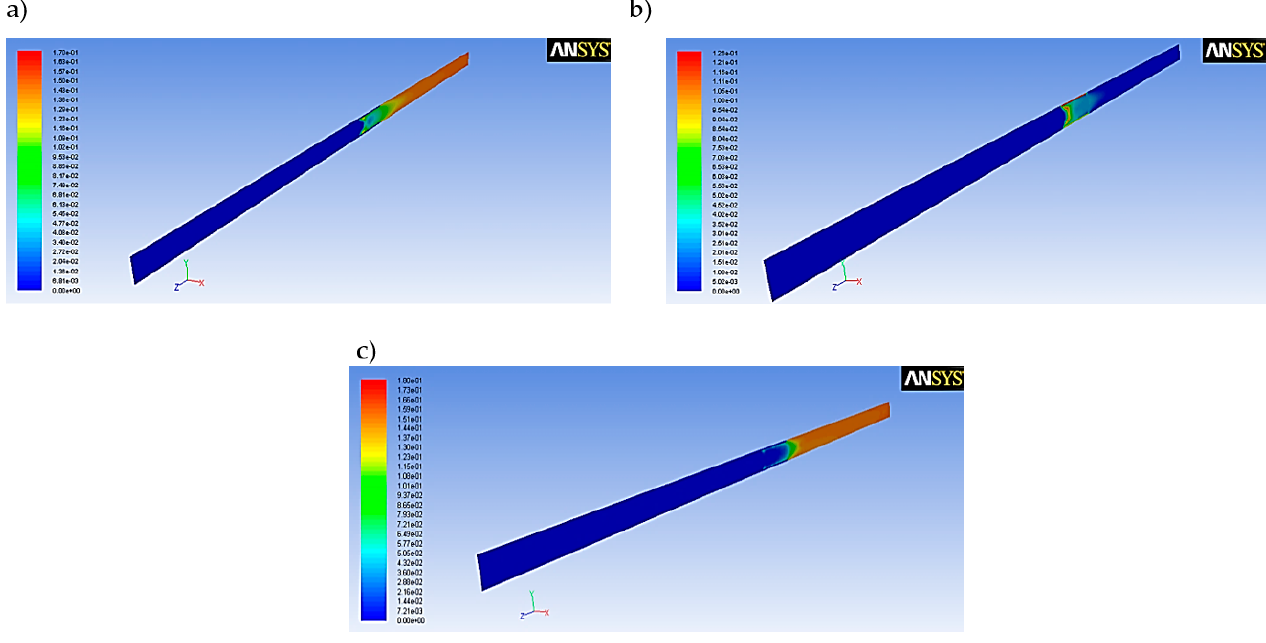
Figure 26. Map of CO 2 variations in the syngas for the numerical simulation: ( a ) coal sample from hard coal mine A in 1040 s, ( b ) coal sample from hard coal mine B in 704 s, ( c ) coal sample from hard coal mine C in 545 s.